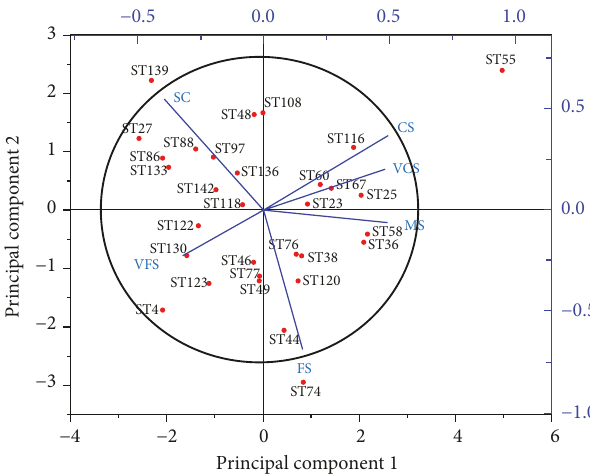
Figure 7: The principal component analysis (PCA) ordination derived from the percentage of grain size analysis in all stations. VCS: very coarse sand (1000 𝜇 m); CS: coarse sand (500 𝜇 m); MS: medium sand (250 𝜇 m); FS: fine sand (125 𝜇 m); VFS: very fine sand (63 𝜇 m); SC: silt-clay ( < 63 𝜇